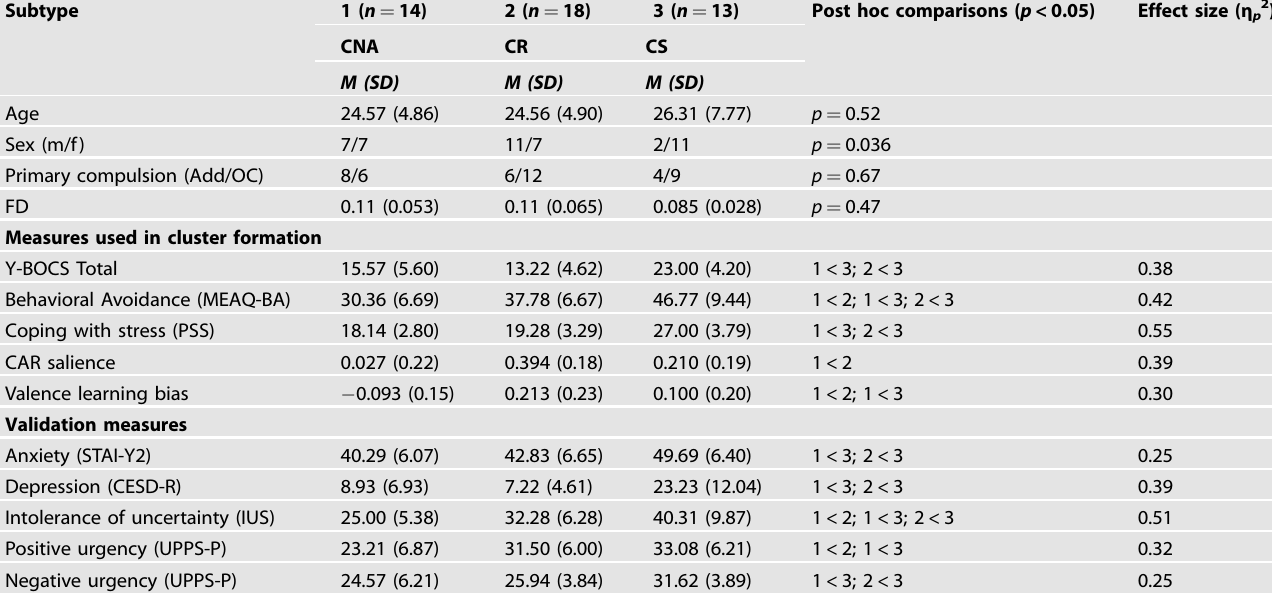
Table 1. Demographic and subtype pro fi les for main input and validating